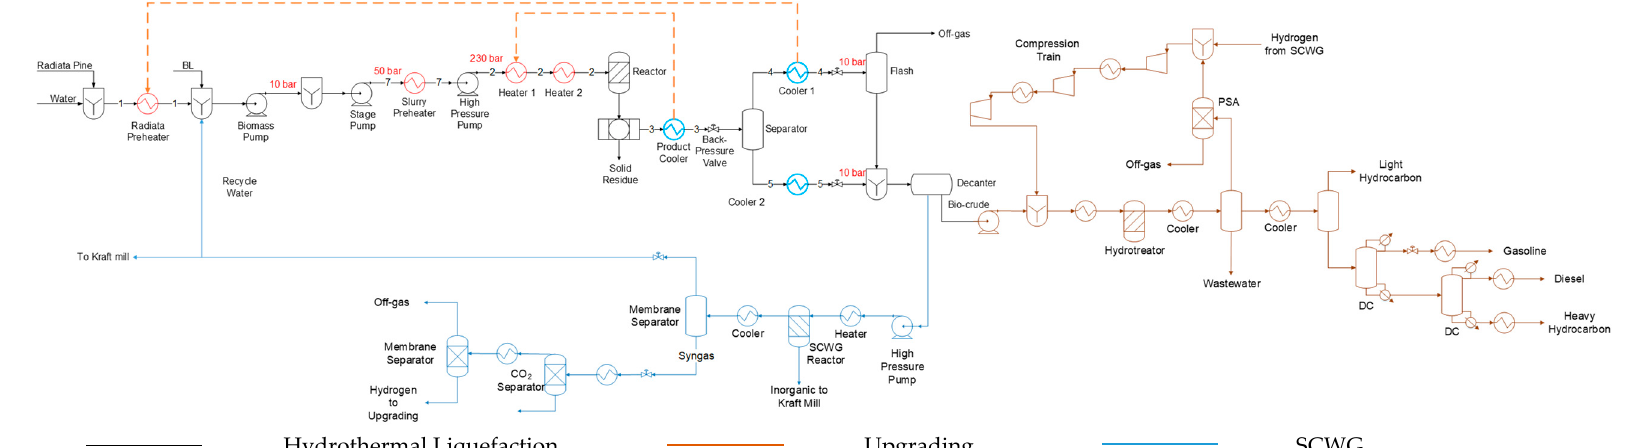
Figure 1. Process flow diagram for the kraft mill-integrated HTL process.